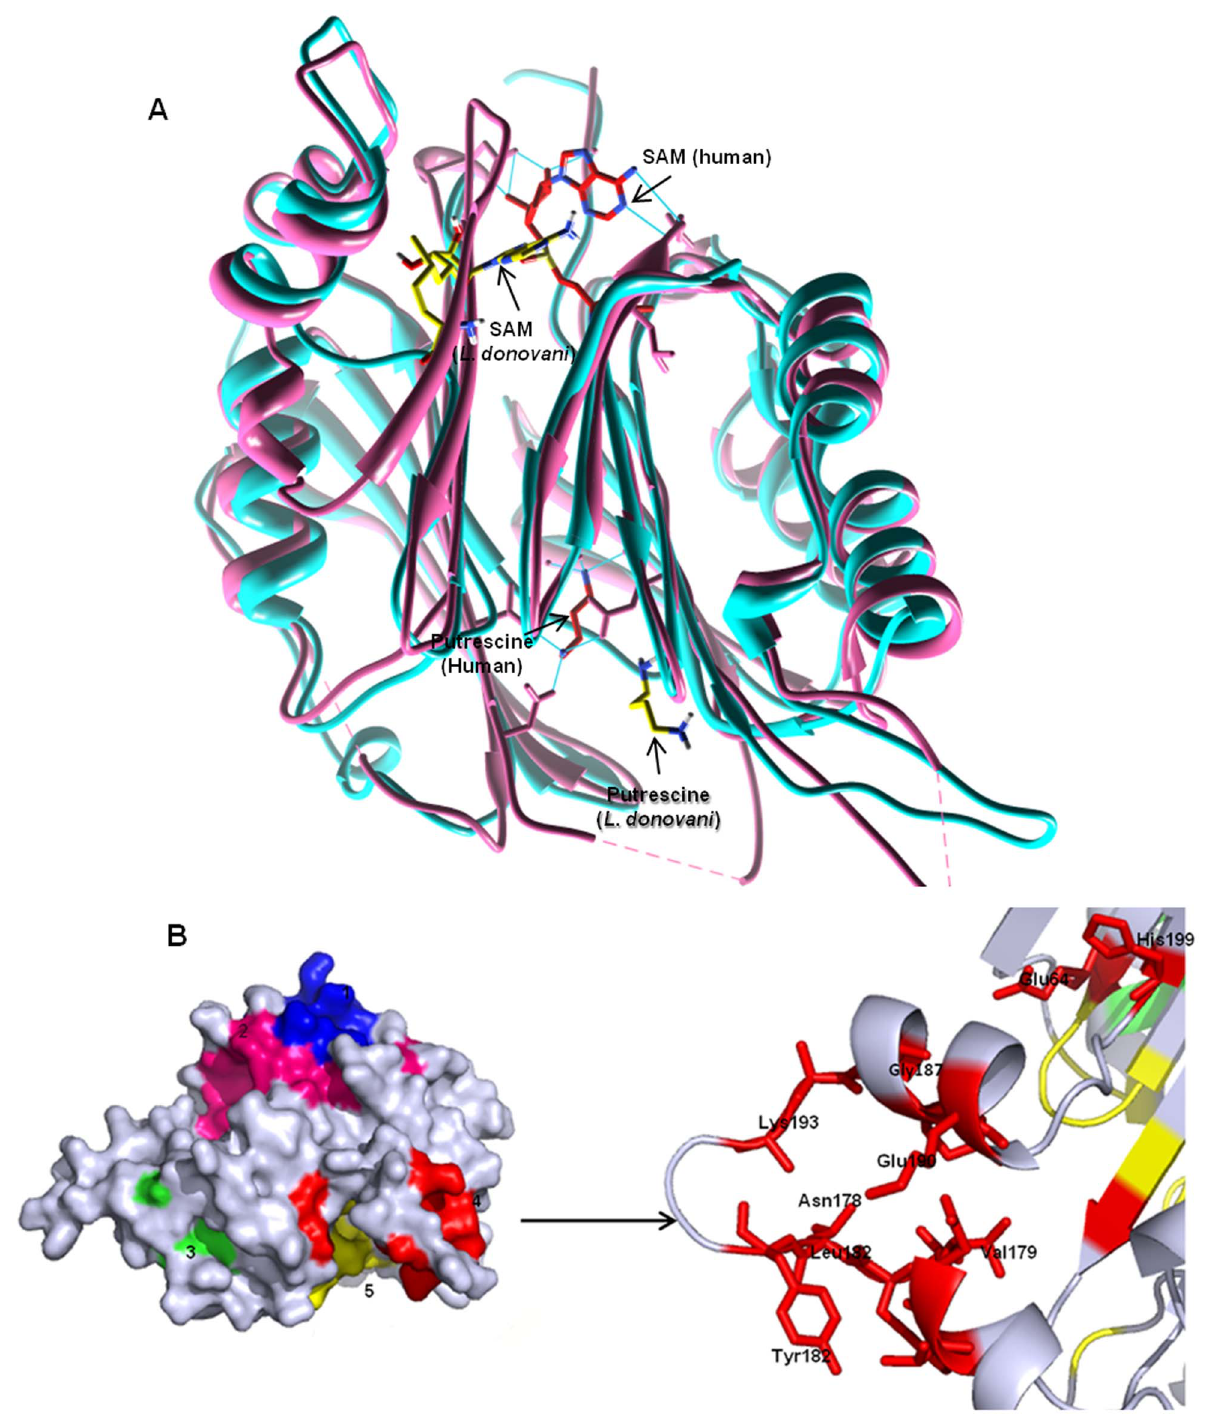
Figure 7. Homology modeling and prediction of SAM binding site. (A) Cartoon representation of the homology model of L. donovani ADL (cyan), superimposed on to the crystal structure of human AD (pink). Ligands observed in the human structure, SAMe (red) and putrescine (red) are also shown, as are the docked SAM and putrescine (yellow) to L. donovani ADL. Figure prepared with the help of Chimera 1.6.1. (B) Surface representation of the L. donovani ADL monomer showing the five binding pockets of SAM as predicted by Q-site prediction server. The different pockets are colored red, yellow, green, magenta and blue. The active site where SAM docked successfully is shown in inset (red). Figures are generated with the aid of Pymol molecular visualization tool [55].